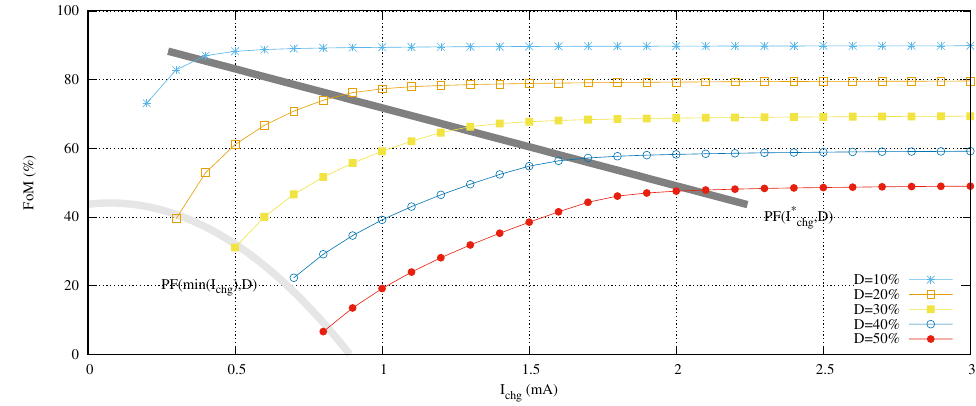
Figure 11. Pareto front curves for minimum charging current and high/low charging